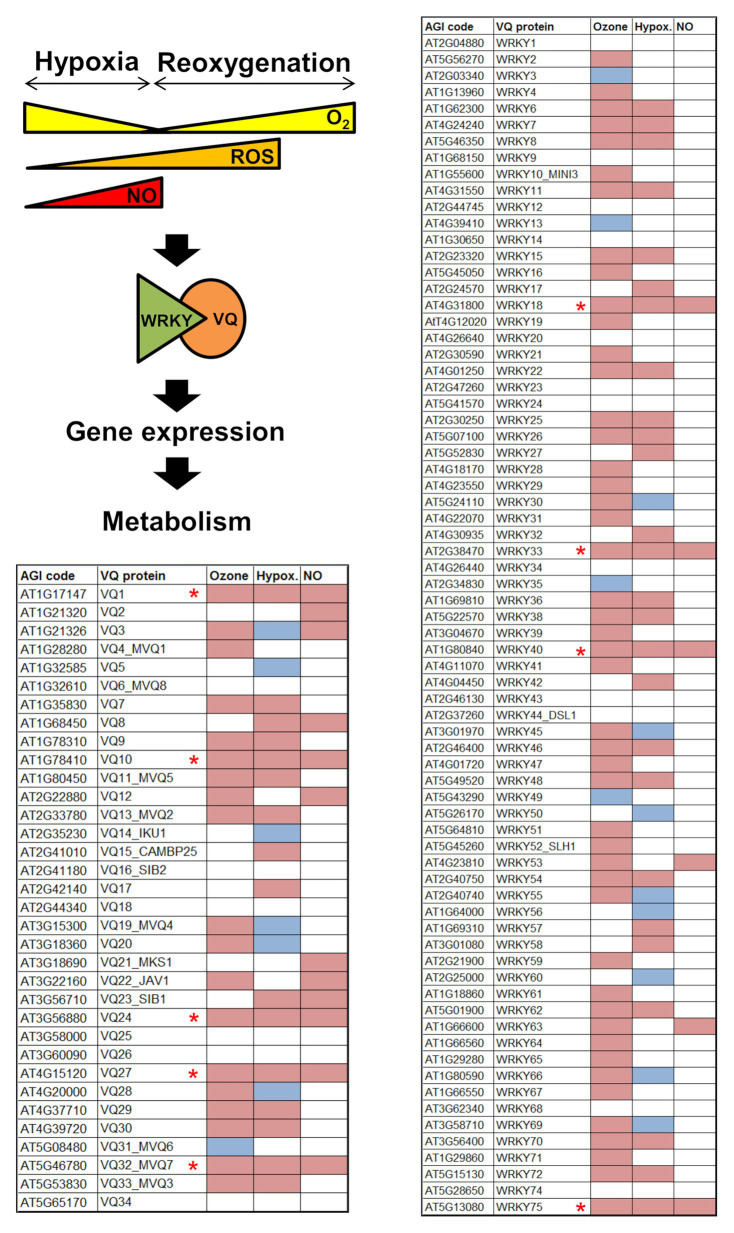
Regulation of Arabidopsis VQ proteins and WRKY transcription factors encoding genes in response to ozone-triggered Reactive Oxygen Species (ROS) production (Ozone), hypoxia (Hypox.), and nitric oxide (NO) treatment (NO). Upregulated (magenta) and down-regulated (blue) transcripts identified in ozone-treated Col-0 plants (Xu et al., 2015), in response to hypoxia and re-oxygenation after hypoxia (Lee and Bailey-Serres, 2019), and in plants exposed to a NO pulse (Castillo et al., 2018; León et al., 2020). Genes marked with red asterisks are upregulated by ozone, hypoxia and NO.